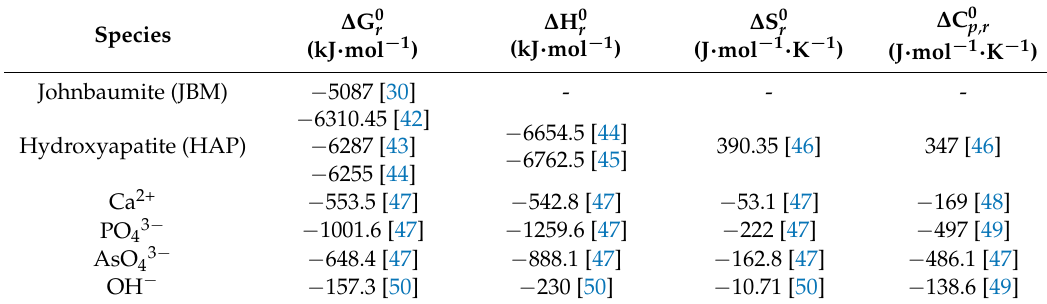
Table 7. Referenced thermodynamic data of formation for johnbaumite, hydroxyapatite, and selected aqueous species (temperature T is 298.15 K and pressure p is 0.1 MPa).